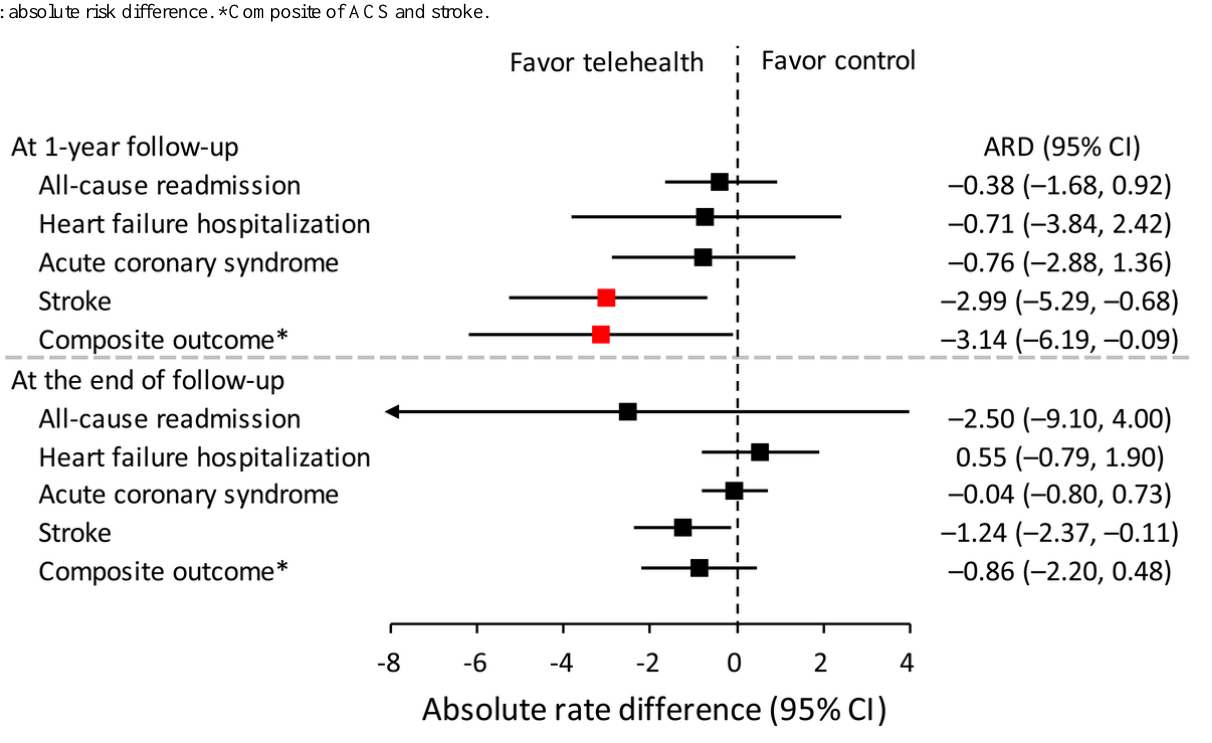
P valueRR a or B b of telemedicine (95% CI)Nontelemedicine, mean (SD)Telemedicine, mean (SD)Outcome